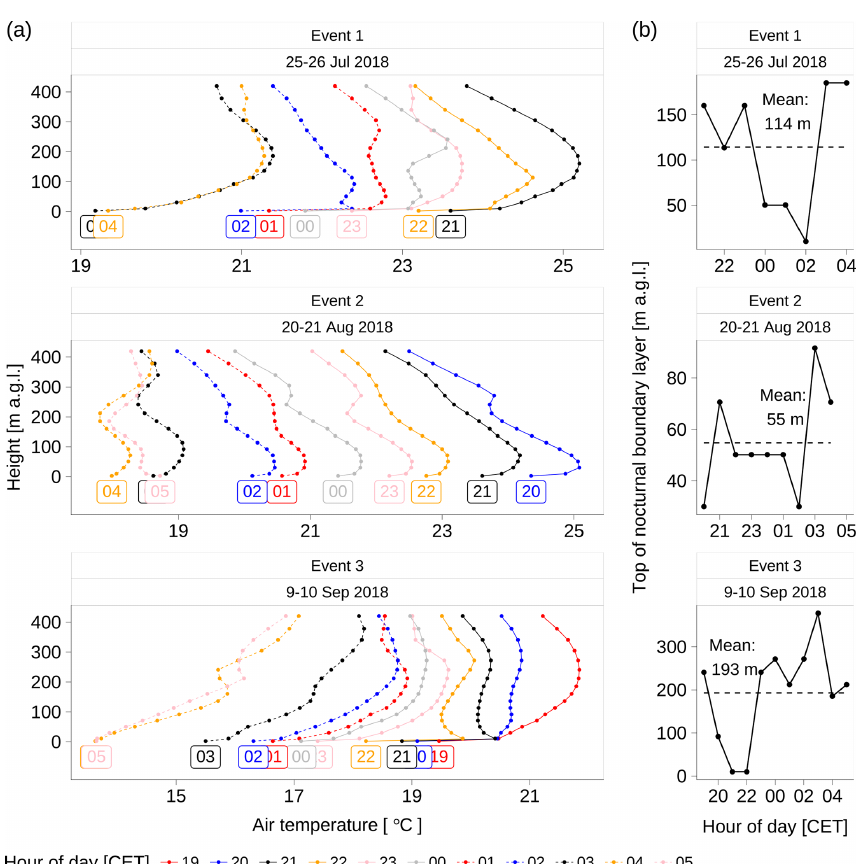
Figure 3. Nocturnal boundary layer (NBL) characterized by the vertical profiles of air temperature for the three events interpolated to the location of the Chamau site based on the analysis data (MeteoSwiss, 2021; Westerhuis et al., 2020) (1.1km horizontal grid spacing, 80 vertical levels) of the regional numerical weather prediction model COSMO: (a) hourly air temperature versus height (ma.g.l.); (b) top of nocturnal boundary layer interpreted by the isothermal height, i.e., ∂T/∂z = 0, where T is air temperature, and z is the height